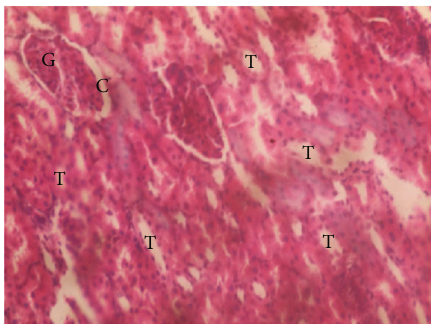
Figure 12: Photomicrographs of the group VI rats showing normal